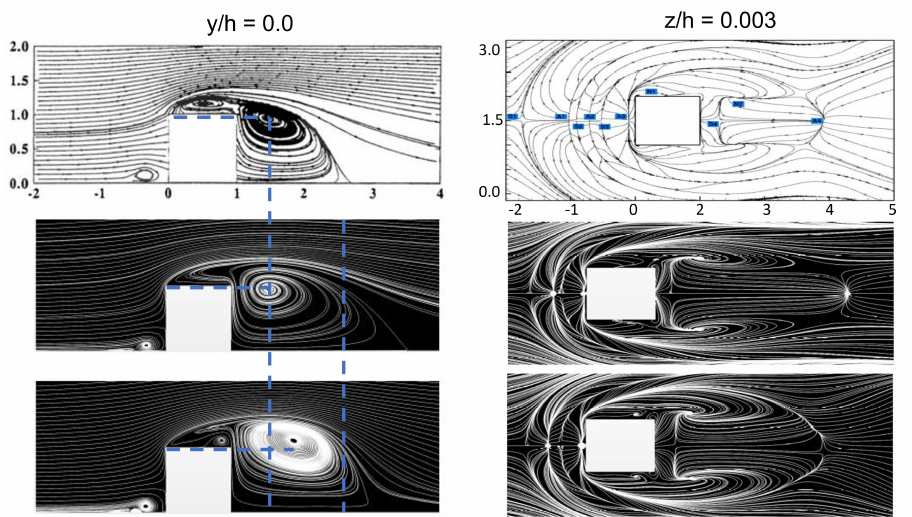
Figure 5. Streamlines on Middle and Top Symmetry Planes Compared to Experiment. Top Left: experiment by Martinuzzi (see Yakhot et al. [42] and Rodi et al. [43]); Top Right: DNS by Curly and Uddin [44]; Middle: modified URANS; Bottom: modified